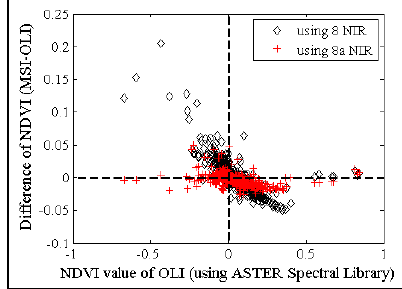
Figure 4. Difference in spectra index (NDVI) between MSI and OLI, based on a collection of 897 spectra from ASTER Spectral Library Version 2.0. For MSI, two indices are obtained using different NIR channels (labelled as “8” and “8a”, see Table 1)